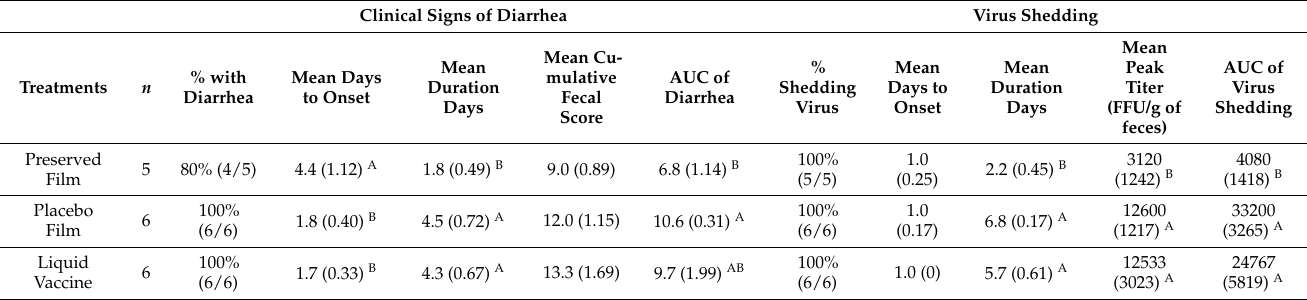
Table 1. Diarrhea and virus shedding in preserved film-vaccinated and control pigs after challenge with virulent Wa HRV. Clinical Signs of